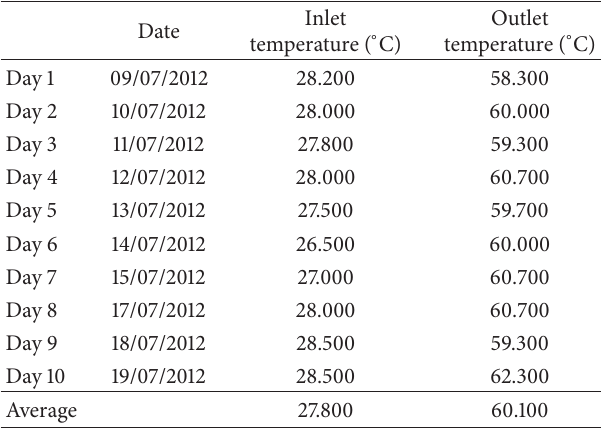
Table 5: Table showing the longitude and latitude of towns in Ogun State [3, 6].